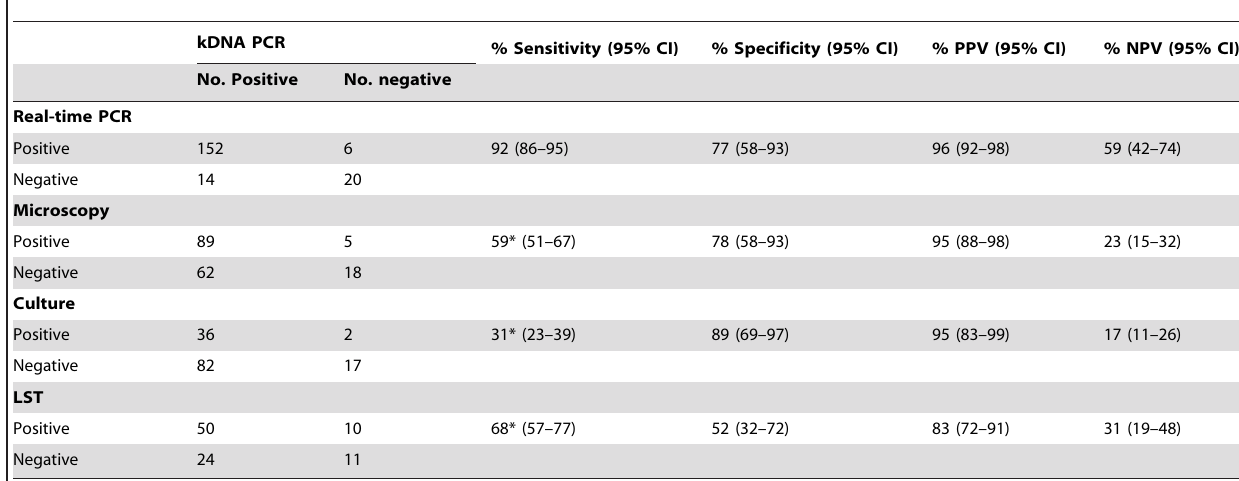
Table 4. Sensitivity, specificity and predictive values for all tested methods using kDNA PCR as the gold standard.